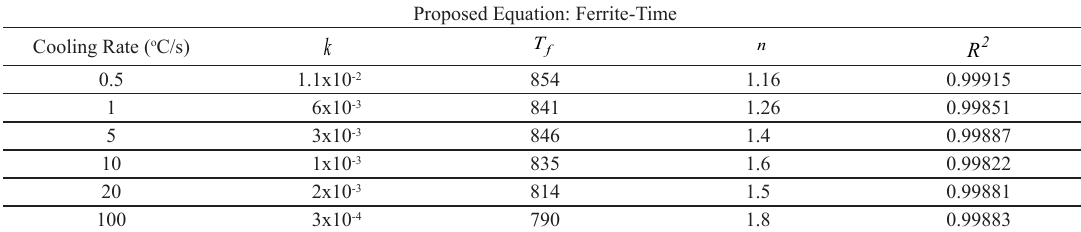
Table 5. Parameters obtained from the fitting of the JMAK equation.